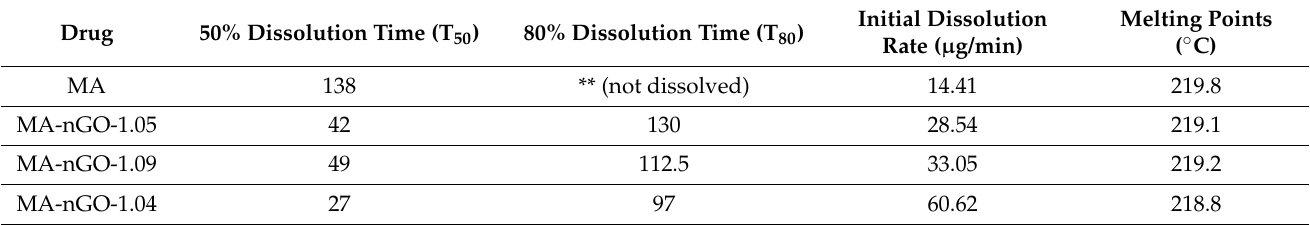
Table 2. Dissolution data at gastro pH (1.4)